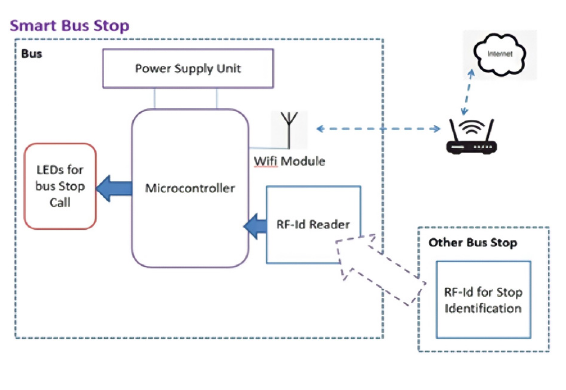
Figure 1. Block diagram of the bus